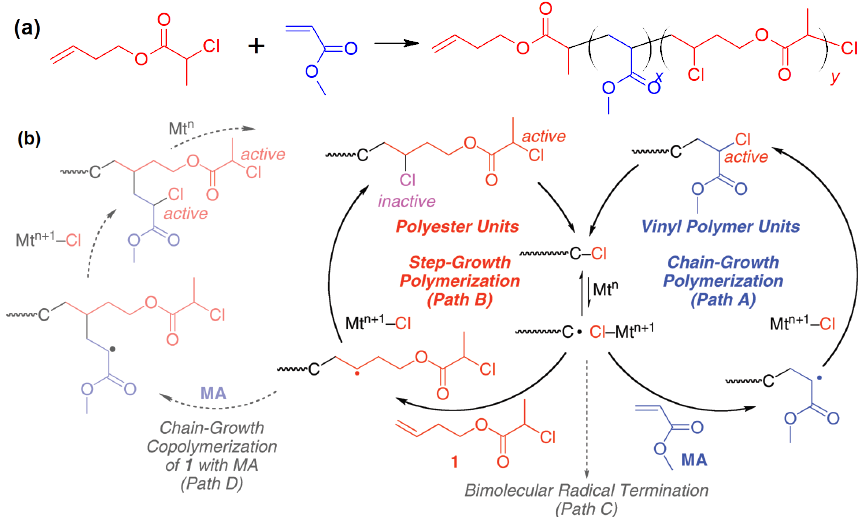
Figure 7. Concurrent ATRP and atom transfer radical addition (ATRA) step-growth polymerization. ( a ) The monomers and the structure of the polymer; ( b ) reaction mechanisms involved in the polymerization. Adapted with permission from [61], Copyright© 2010 American Chemical